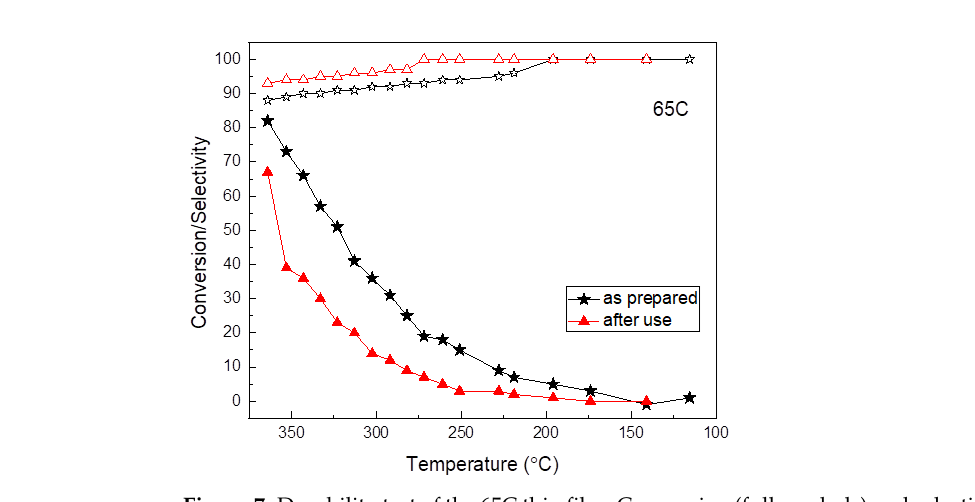
Figure 7. Durability test of the 65C thin film. Conversion (full symbols) and selectivity (open symbols) as a function of temperature.